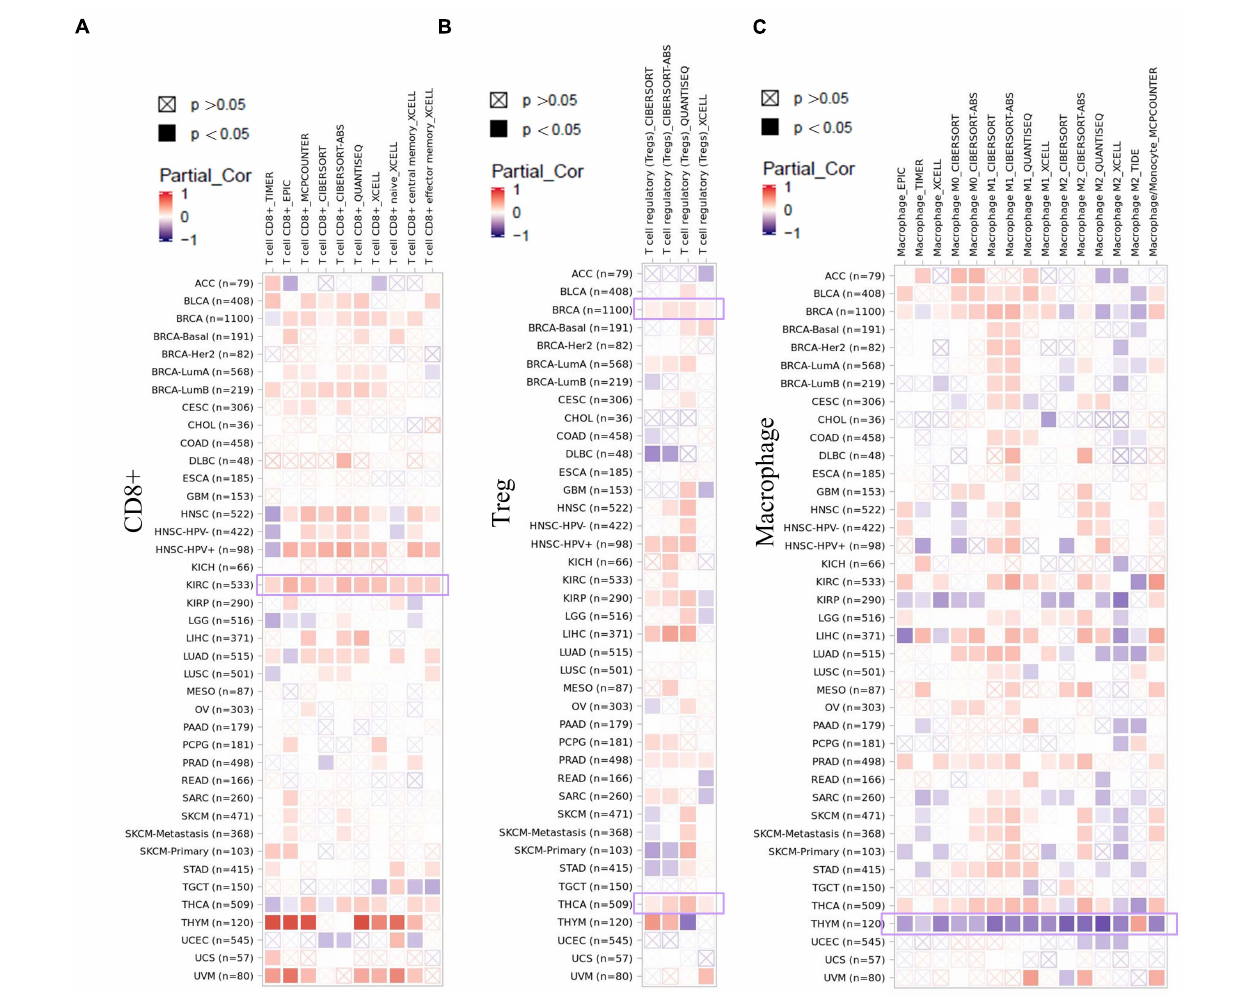
Frontiers in Genetics |